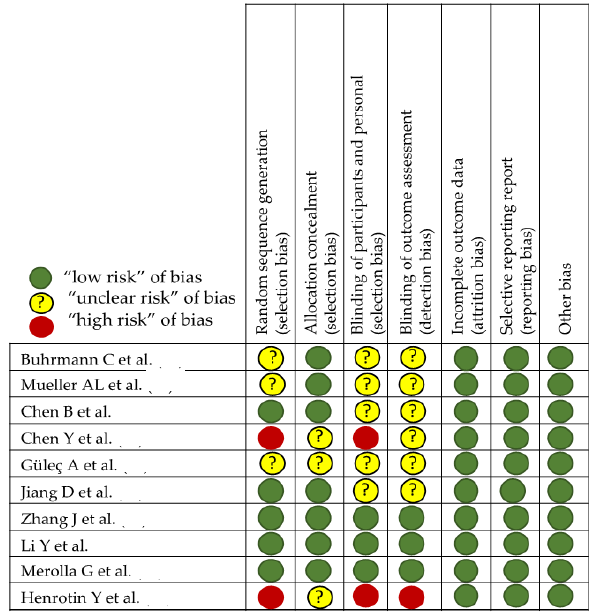
Figure 2. Flow chart used in the bibliographic search in humans and animals.